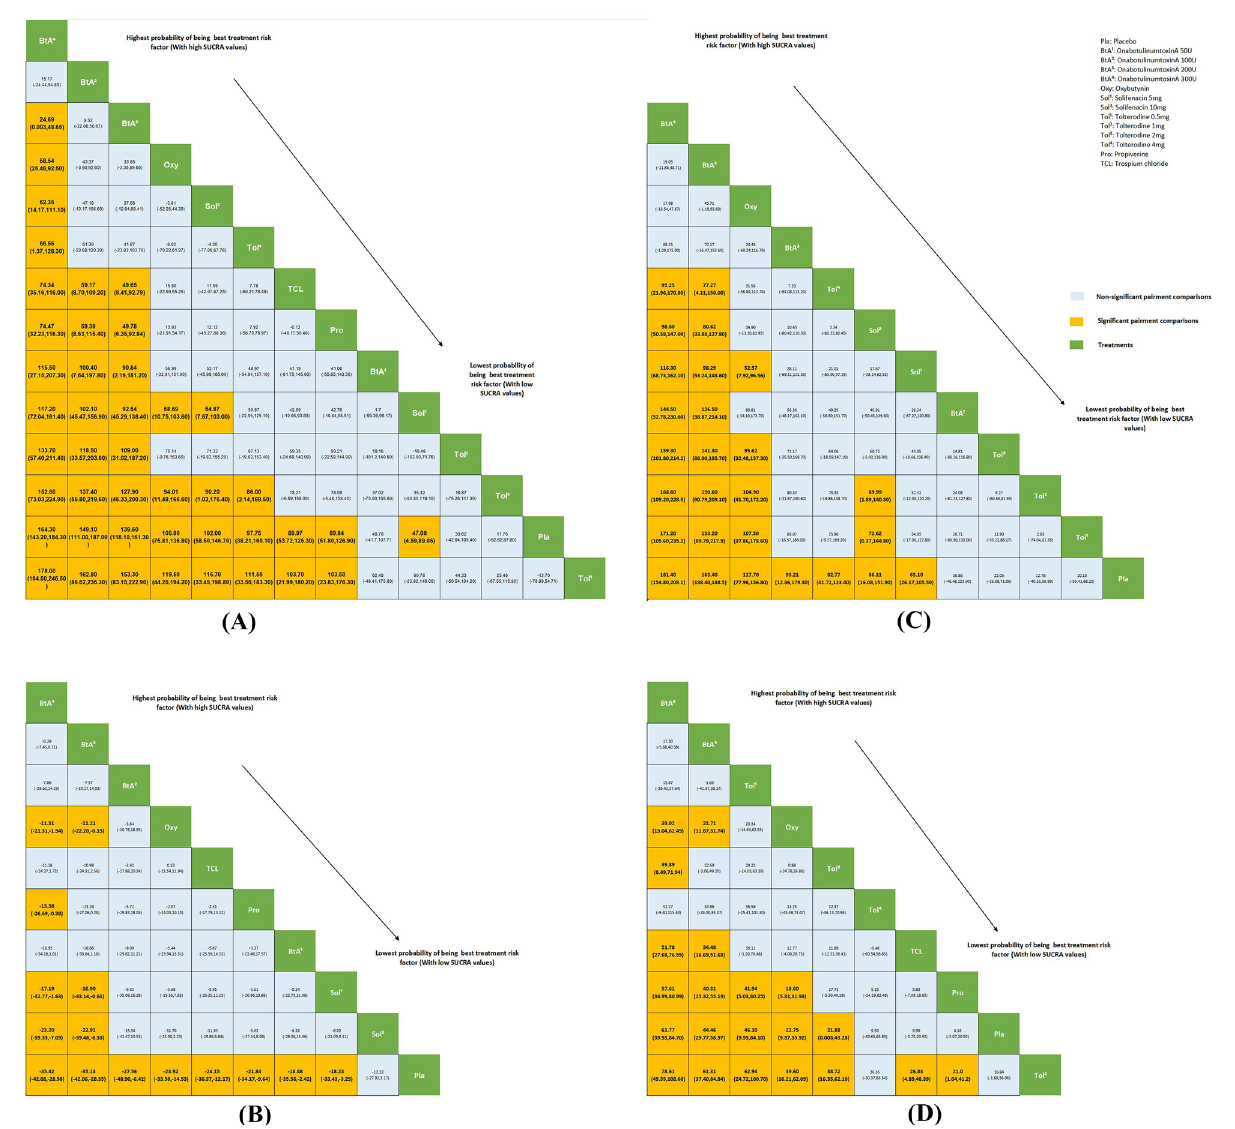
Figure 2. Pairwise comparison based on urodynamic results according to network meta-analysis. Treatments are orders in the rank of their chance of being the best treatment. The green boxes are treatments, the orange boxes are significant pairment comparisons, the cornflower blue boxes are non-significant pairment comparisons (the numbers are mean and the credible intervals). ( A ) MCC comparison of multiple treatments. ( B ) Pdet max comparison of multiple treatments. ( C ) Vol at First IDC comparison of multiple treatments. ( D ) Bladder compliance comparison of multiple treatments. Pla Placebo, BtA 1 OnabotulinumtoxinA